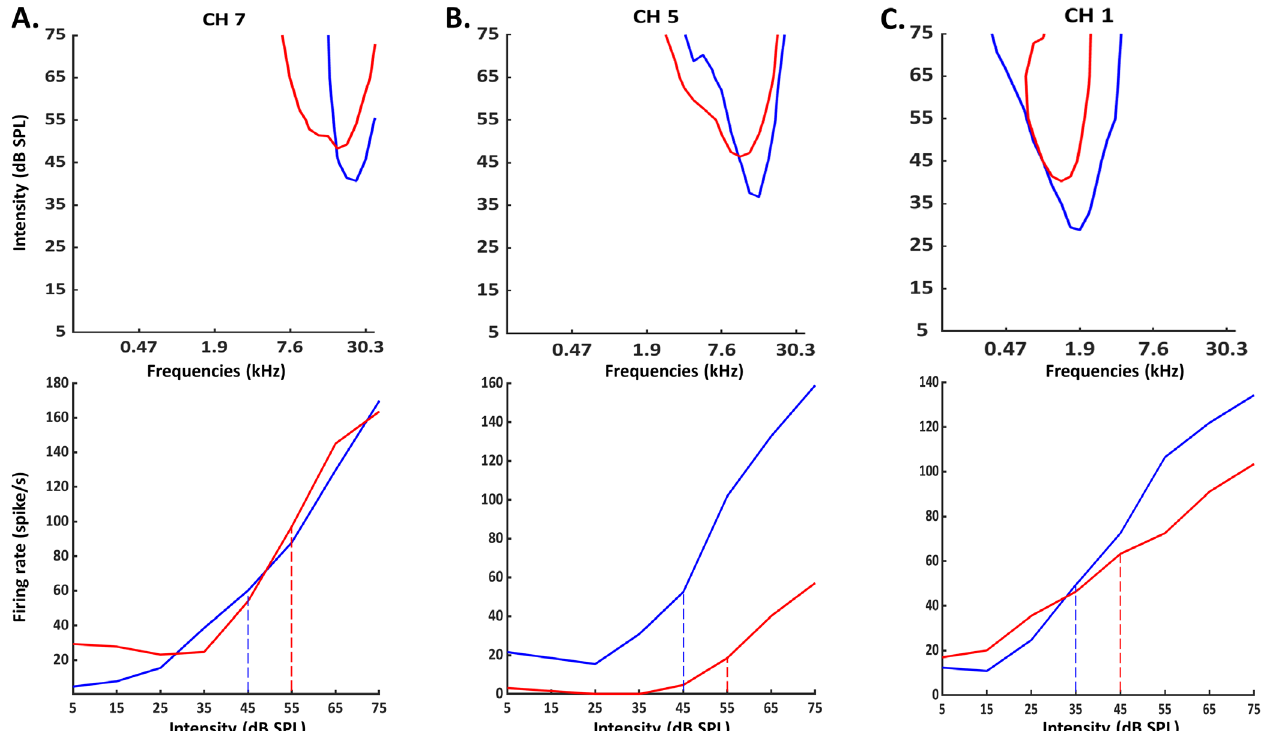
Figure 5. Examples of Frequency Response Areas (FRA) and rate-level functions obtained before and after CI insertion. Top: For each example, the bleu curve represents the FRA obtained before CI insertion and the red curve the FRA obtained after CI insertion. Bottom: For each example, the bleu curve represents the rate-level function obtained before CI insertion and the red curve the rate-level function obtained after CI insertion. A. In this case, the threshold (defined as a response above spontaneous activity plus 6 sem) increased from 45 to 55dB and there was only a small decrease in evoked firing rate at 75dB. B. In this case, the threshold (defined as a response above spontaneous activity plus 6 sem) increased from 45 to 55dB and there was a large decrease in evoked firing rate at 75dB. C. In this case, the threshold (defined as a response above spontaneous activity plus 6 sem) increased from 35 to 45dB and there was a decrease in evoked firing rate at 75dB. Note that in the three cases, there was not increase in the slope of the rate level function after CI insertion: the slope was either similar or slightly smoother after than before CI insertion.